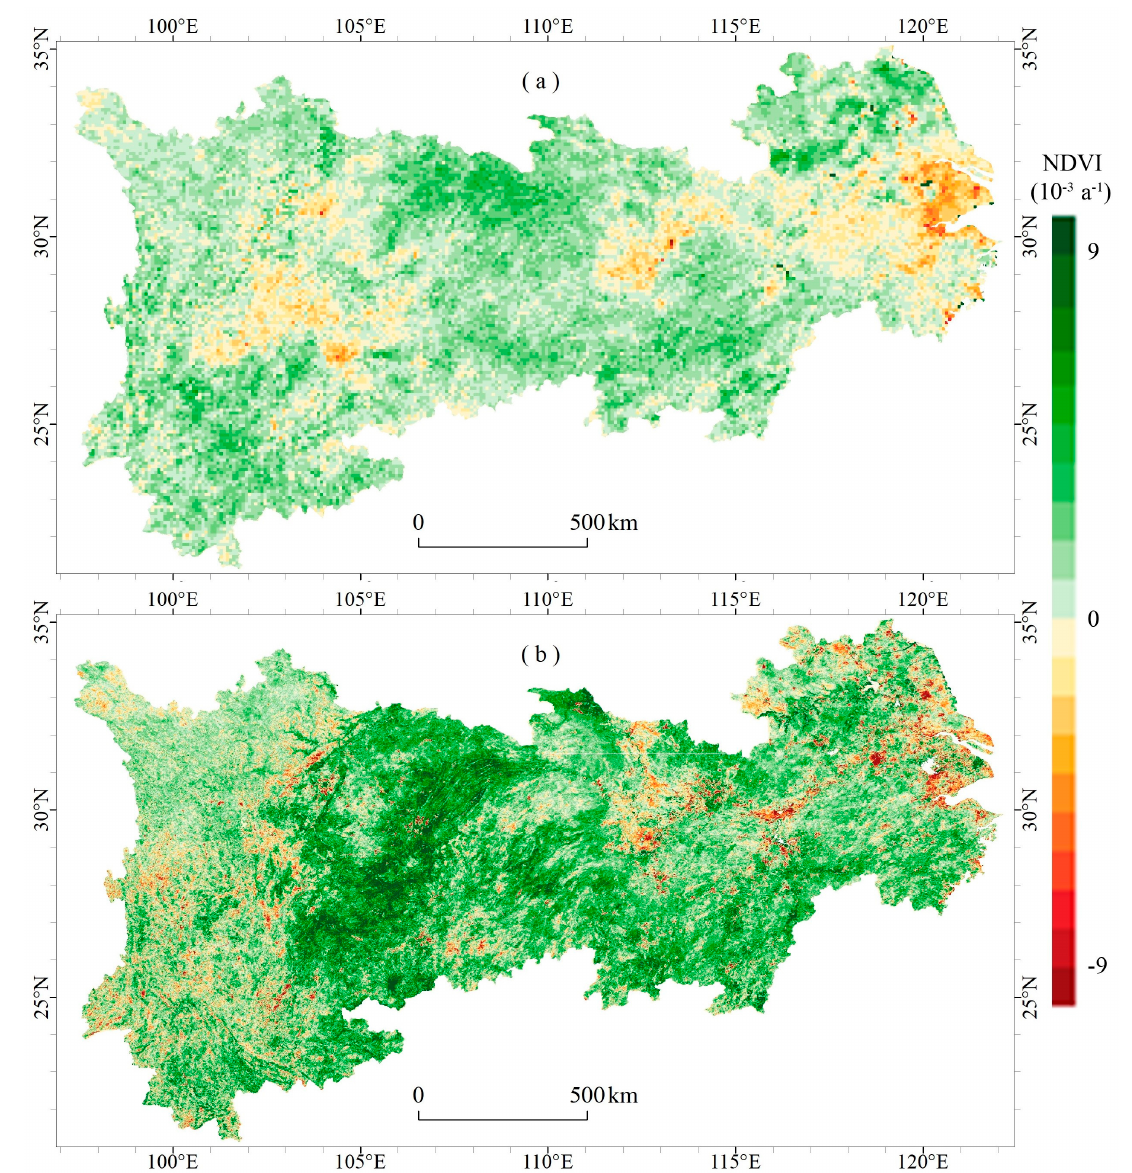
Figure 4. Spatial patterns of the growing season NDVI trends in YREB: ( a ) 1982–2003 and ( b ) 2003– 2019.